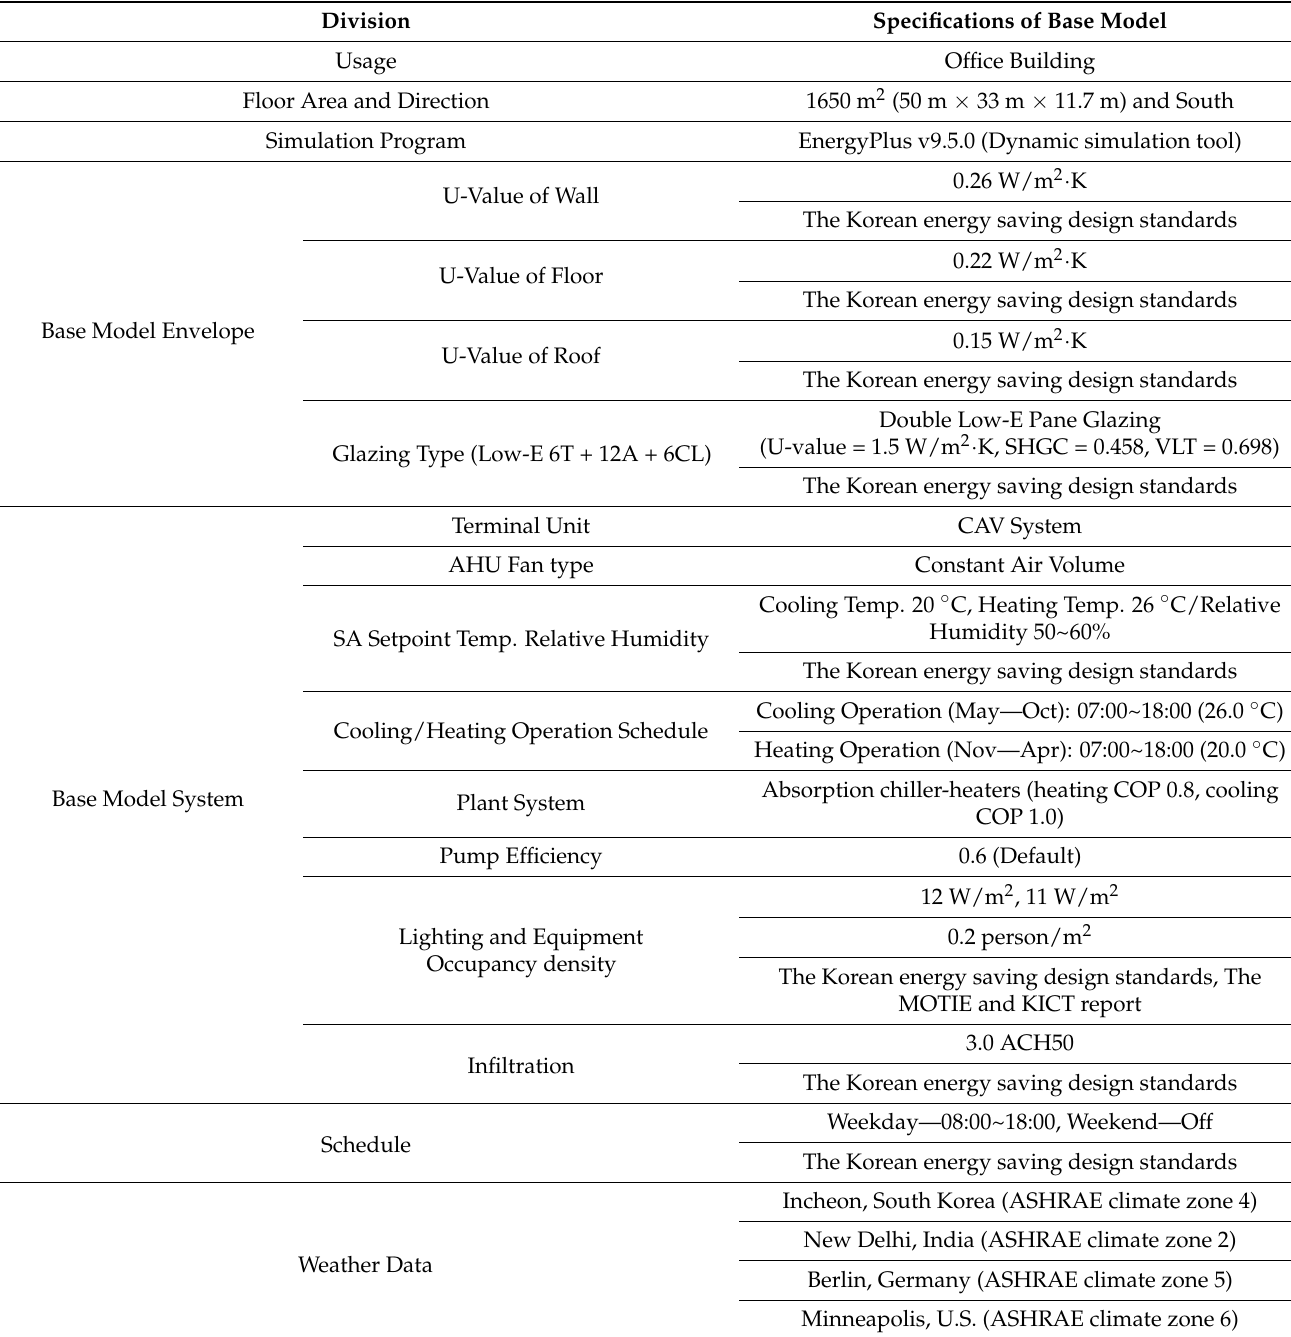
Table 1. Properties of the base simulation